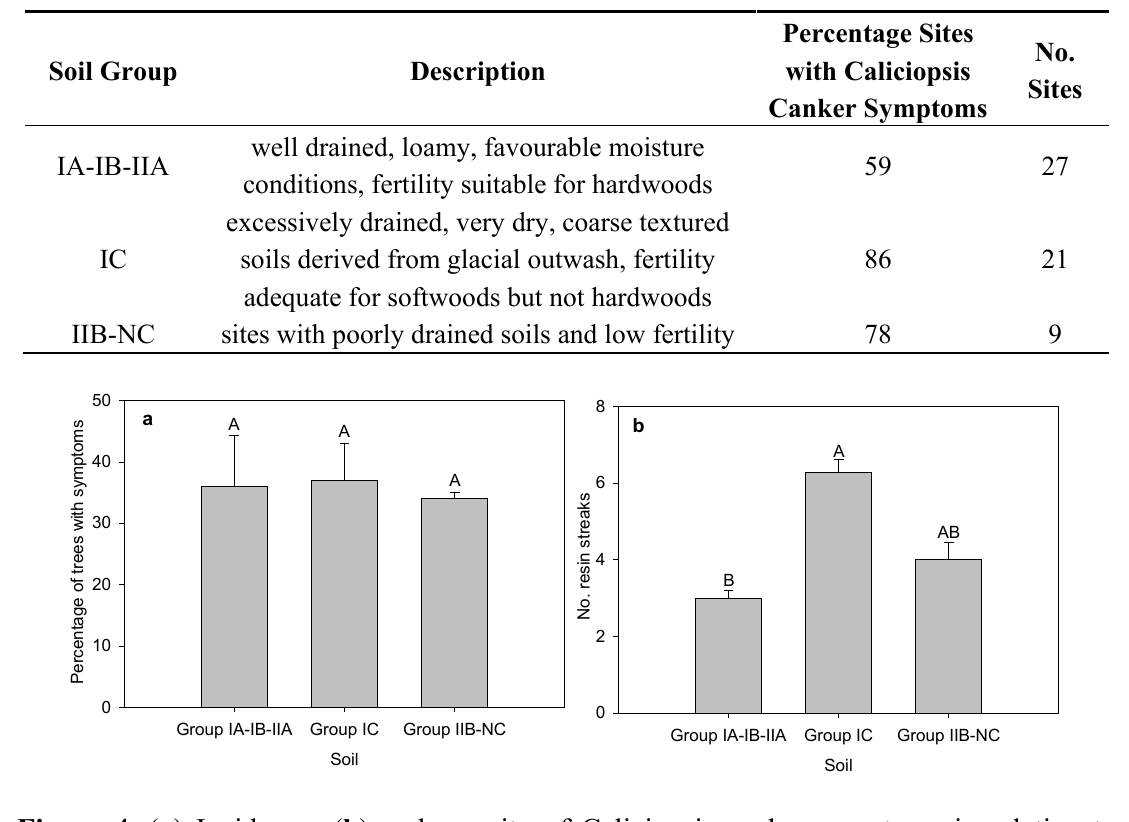
Figure 4. ( a ) Incidence; ( b ) and severity of Caliciopsis canker symptoms in relation to important forest soil groups. Bars represent means and standard errors. Values with the same letter are not statistically different (α =